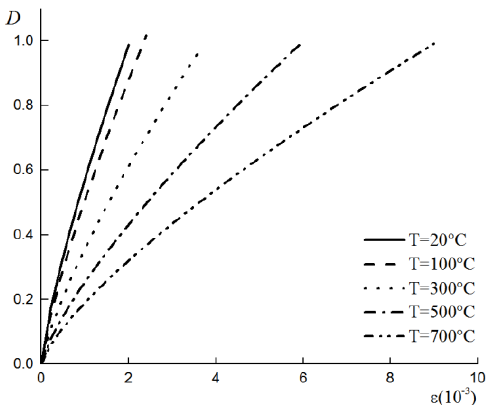
Figure 4. Comparison of simulation results and test results for C40 concrete.